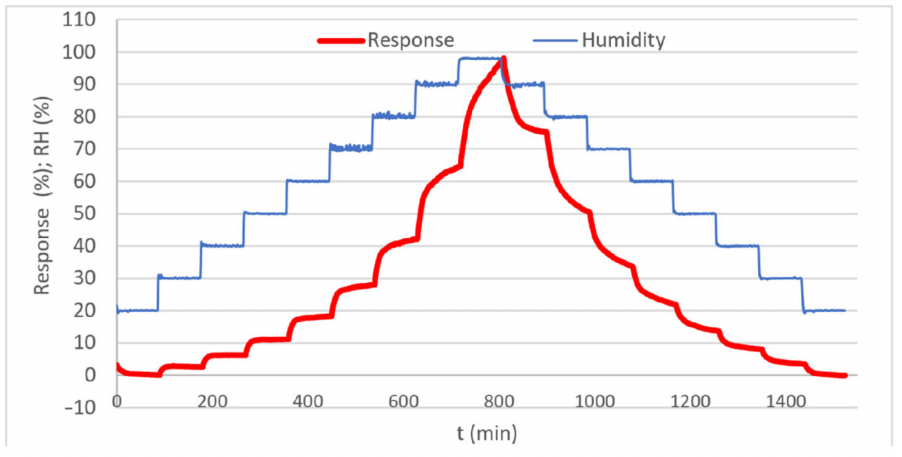
Figure 12. Response of the graphene-based, rectangle-type sensor to RH (condition: temperature of 25 ◦